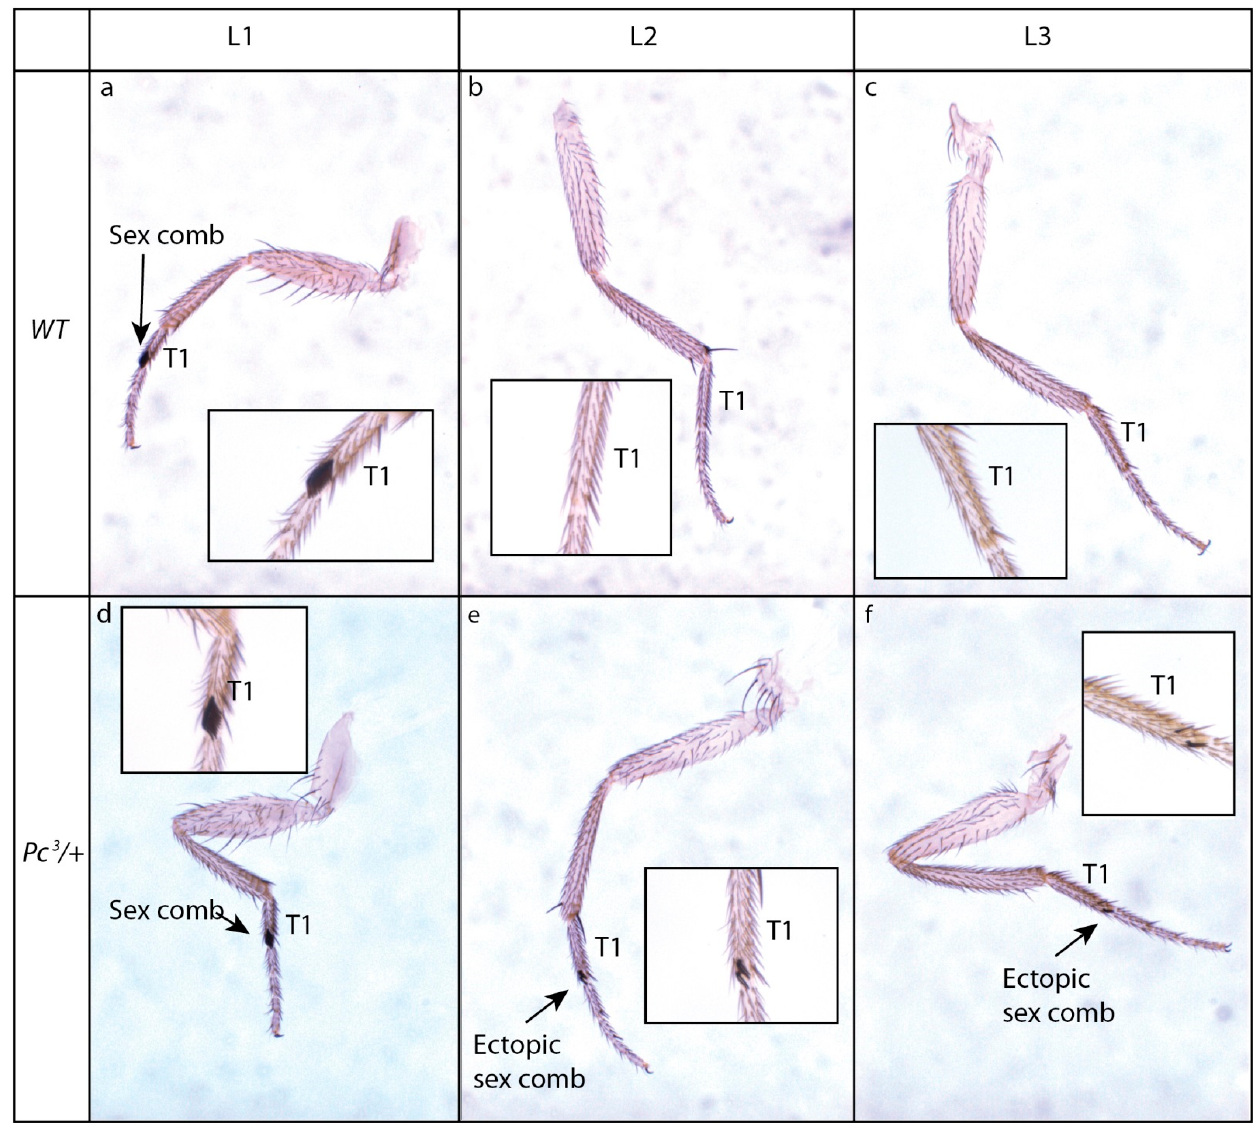
Figure 3. Ectopic sex combs of a PcG mutant. ( a – f ): Sex comb phenotype of Polycomb mutant. Sex combs are organs made of modified bristles present in males on the first tarsal segment (T1) of the first legs (L1) ( a – c ). The Polycomb mutant Pc 3 shows dominantly ectopic partial sex combs on more posterior legs (L2, L3) ( d – f ).